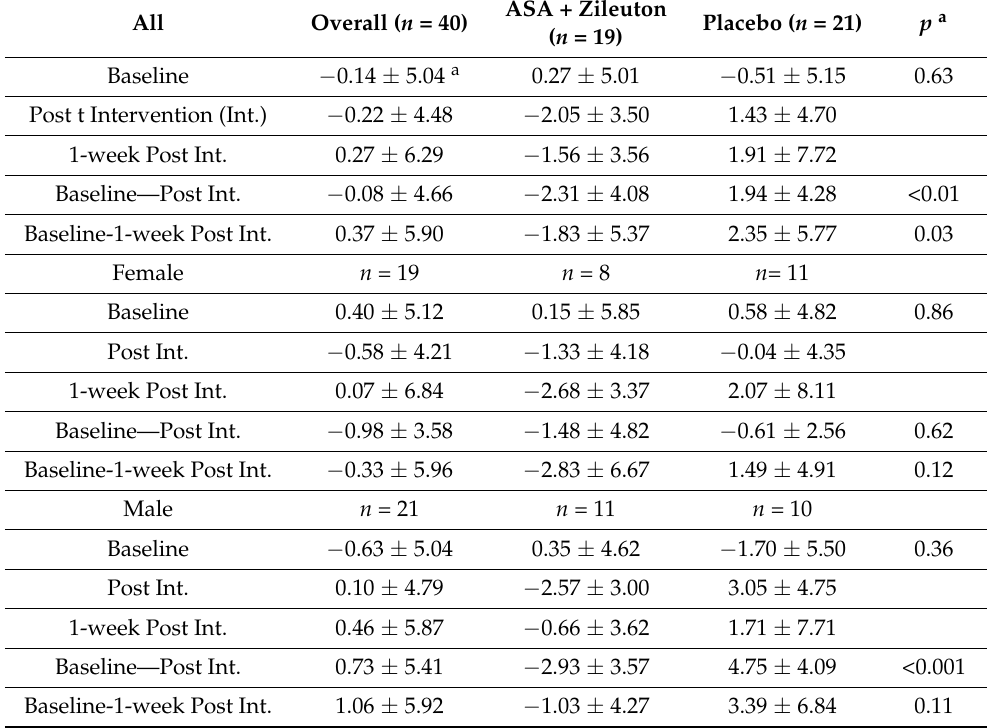
Table 5. Baseline and changes in a squamous dysplasia-associated gene expression signature derived from bronchial brushings by Beane [22]; data is presented as mean ± standard deviation. ASA + Zileuton All Overall ( n = 40) Placebo ( n = 21) p a ( n = 19) Baseline − 0.14 ± 5.04 a 0.27 ± 5.01 − 0.51 ± 5.15